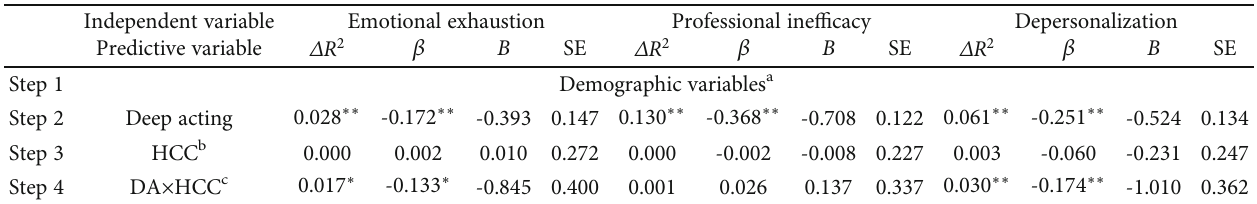
Table 4: Coe ffi cients of multiple linear regression of deep acting, hair cortisol content, and their interaction against Maslach job burnout ( n = 229 ).